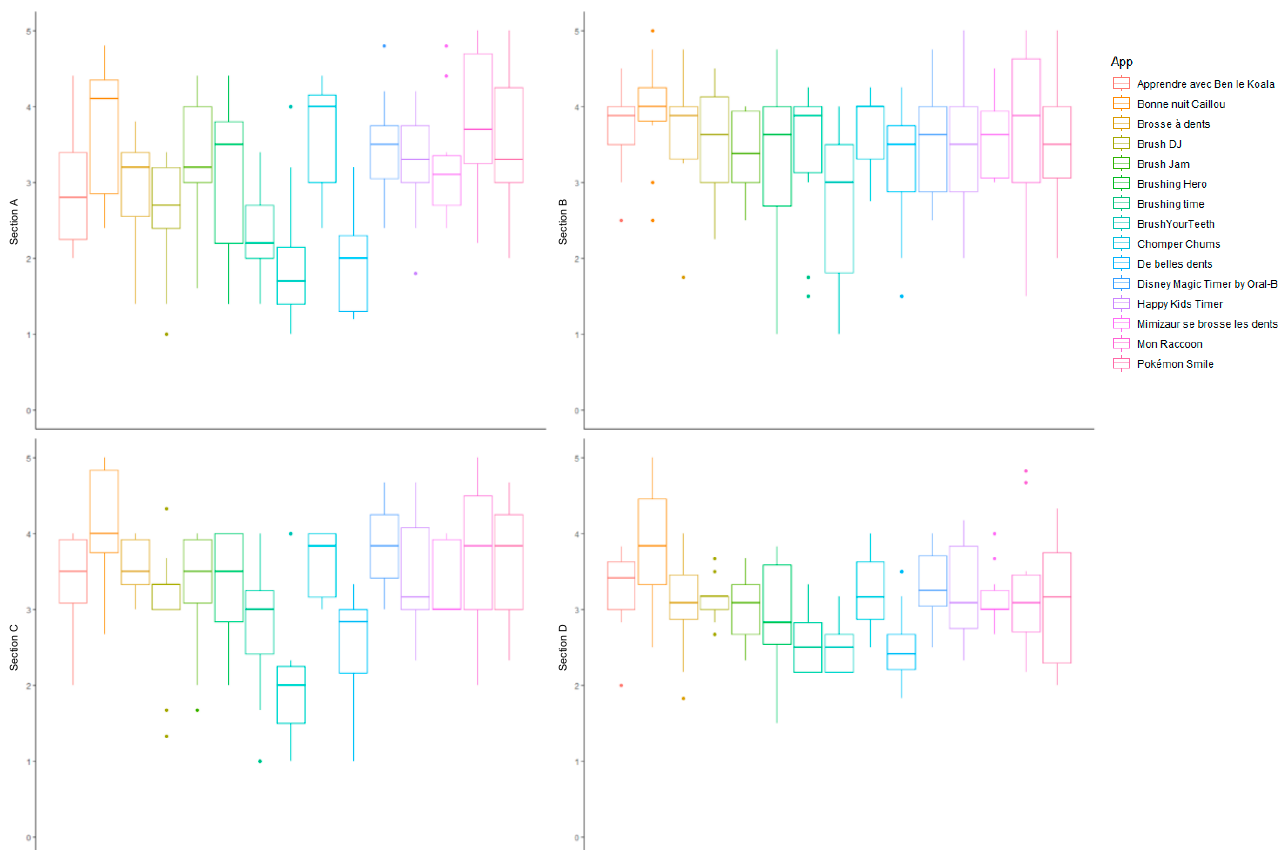
Figure 3. Qualitative evaluation of oral hygiene-related mobile apps for children available in Sub- Saharan Africa. Section A: engagement; section B: functionality; section C: aesthetics; section D: in- formation.